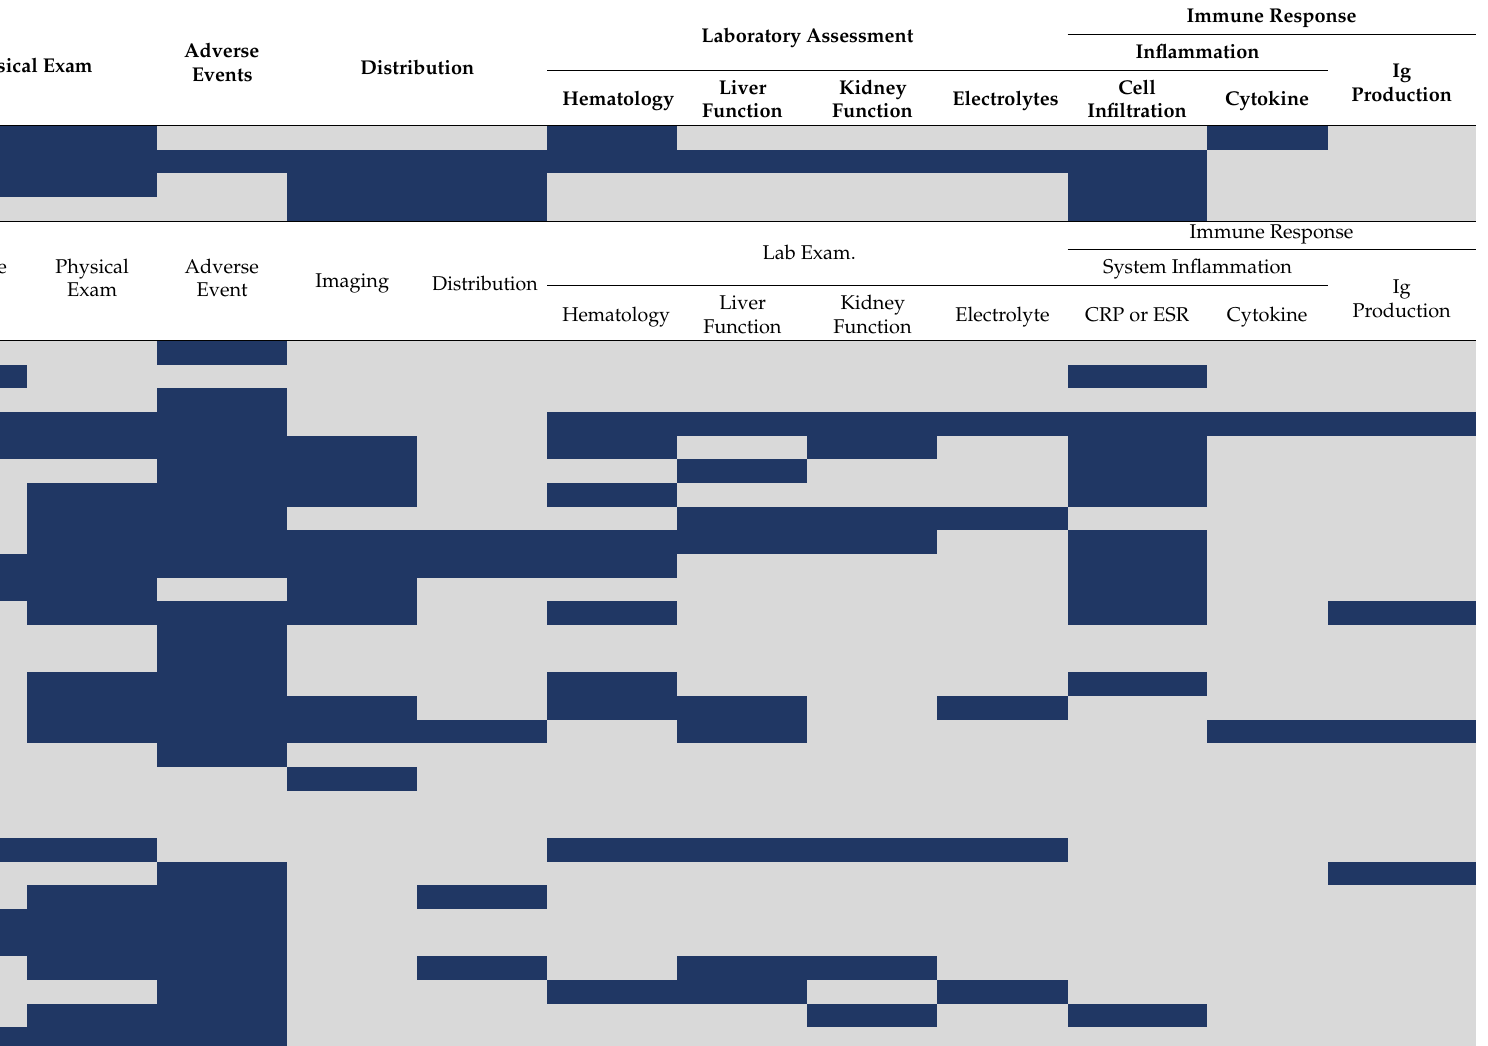
Table 1. Safety monitoring in phage therapy